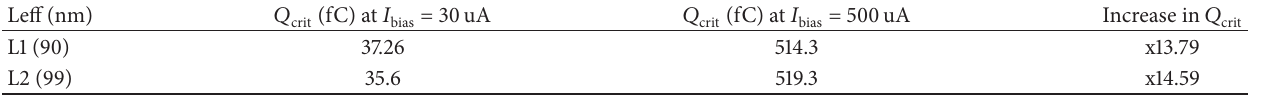
Table 2: 𝑄 improvement with current bias for different effective length at 0.5 GHz. crit